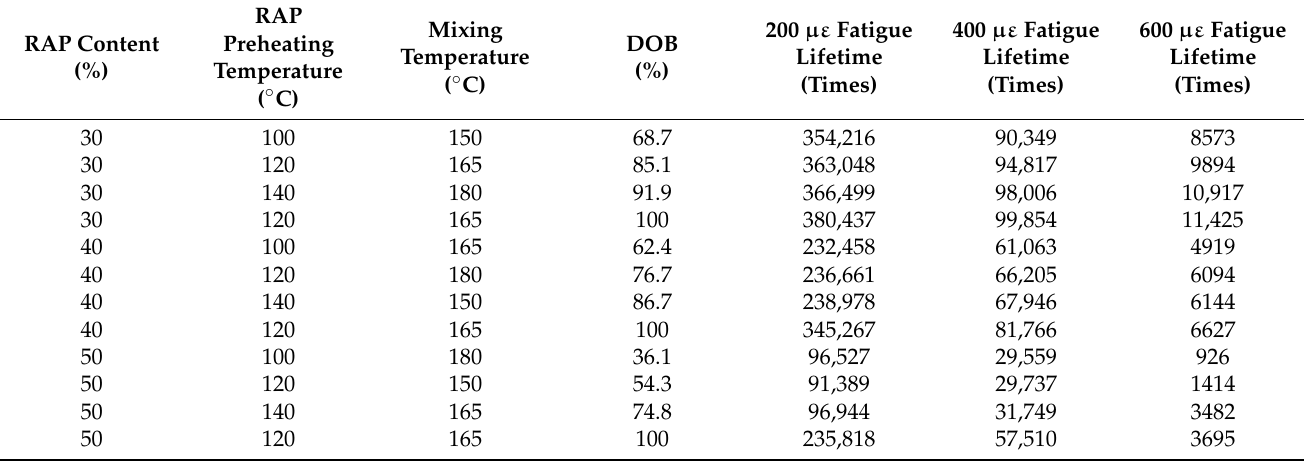
Table 8. Test results of the four-point bending fatigue